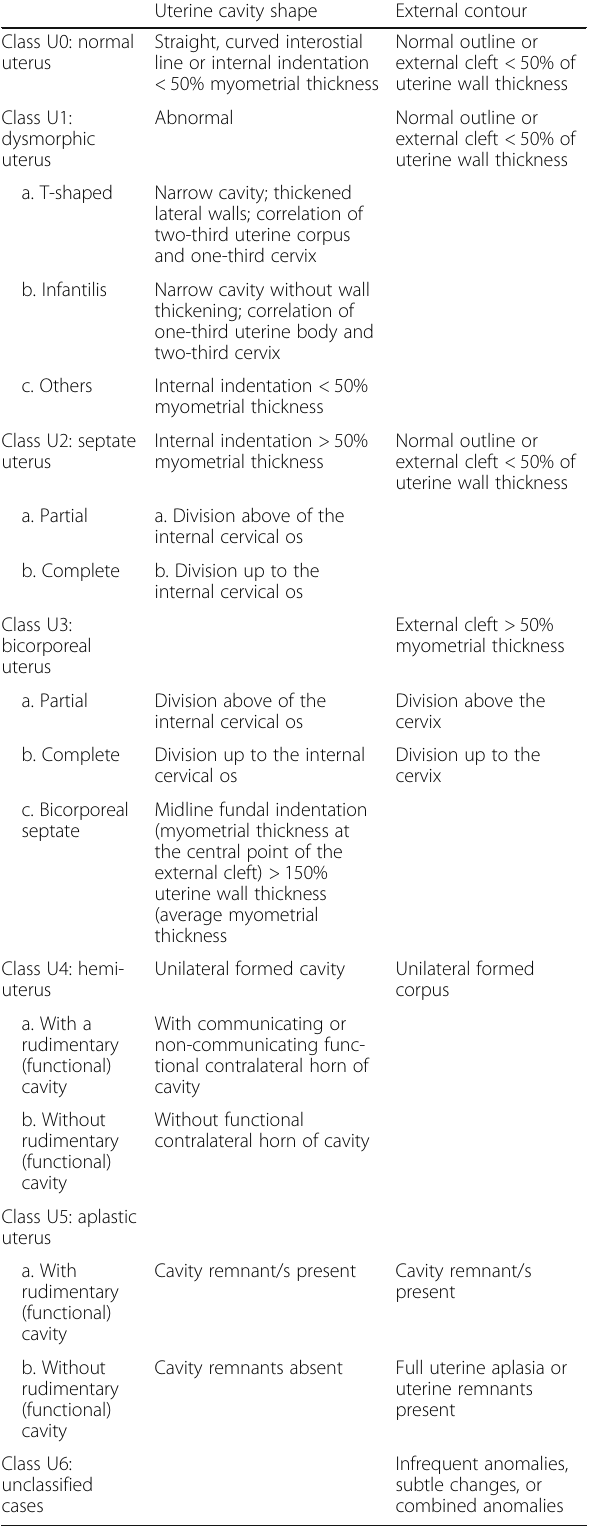
Table 2 ESHRE – ESGE main classes, subclasses, and coexistent cervical/vaginal subclasses